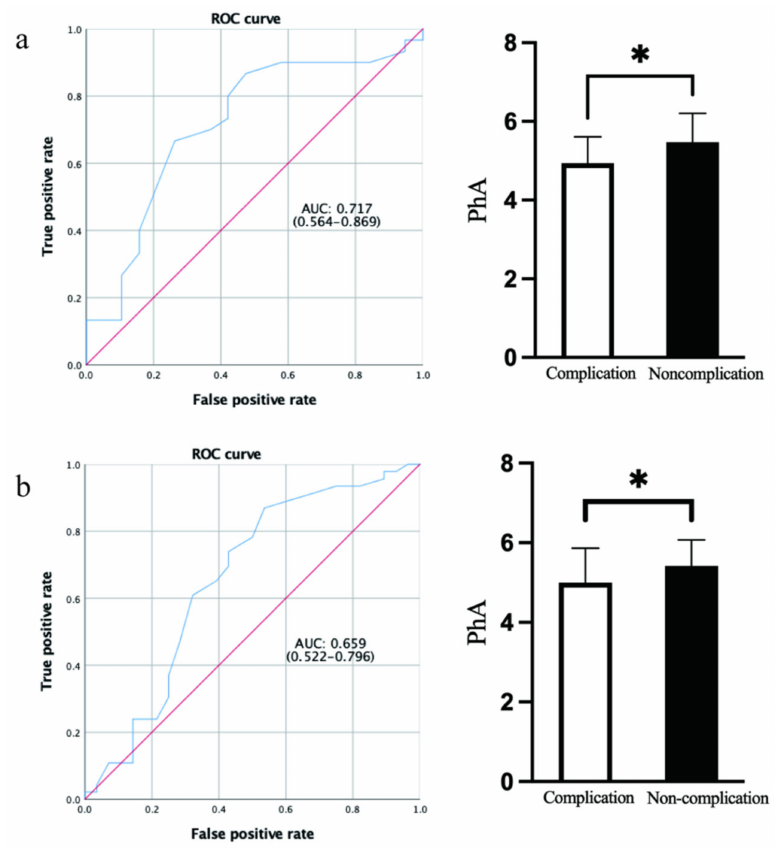
Figure 4. ROC curves of PhA to predict the postoperative complications and bar graphs of PhA values between the complication group and the non-complication group. ( a ) The results of 49 participants with pancreatic head cancer. ( b ) The results of 74 participants who underwent pancreaticoduodenec- tomy. * p <